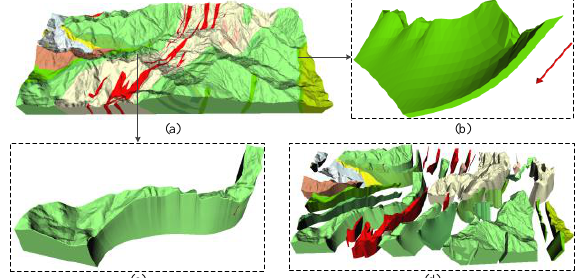
Figure 6. 3D regional geological modelling including rock mass, stratum, dykes etc. (a) regional geological model; (b) stratum model conformed to attitudes; (c) long-narrow rock mass model; (d) explosive view of geological units.